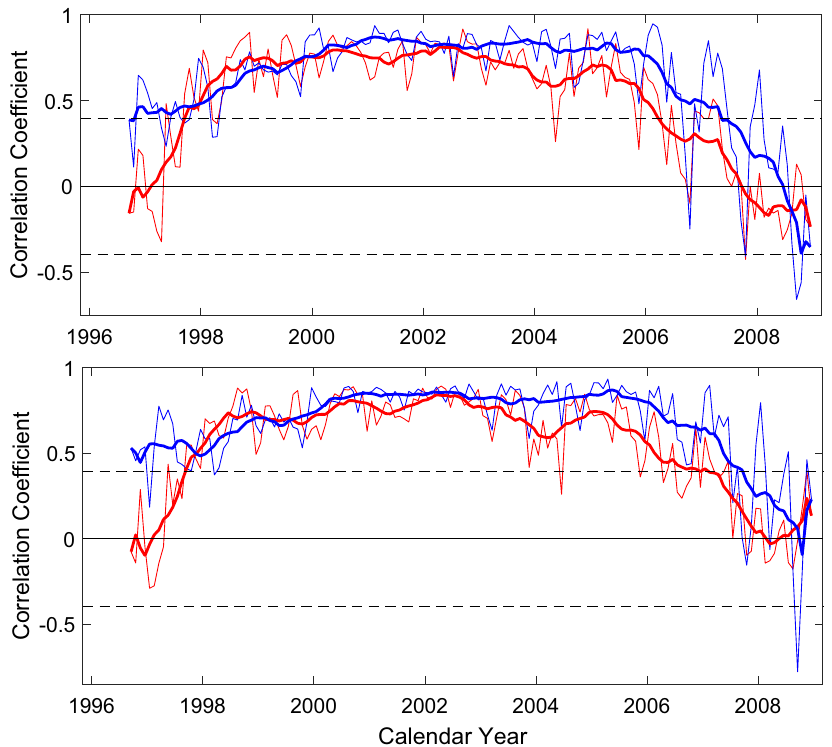
Figure 4. Top panel: cross correlation coefficient between latitude distribution of CI measured at the east solar limb, respectively with the magnetic field MF s (red thin line) and the small-scale magnetic elements (Component-II, blue thin line), at a certain month. The thick red/blue line is the 12-point smoothing of the corresponding thin red/blue line, and the two horizontal dashed lines show the 95% confidence level. Bottom panel: the same as the top panel, but CI measured at the east solar limb is replaced by CI at the western limb.